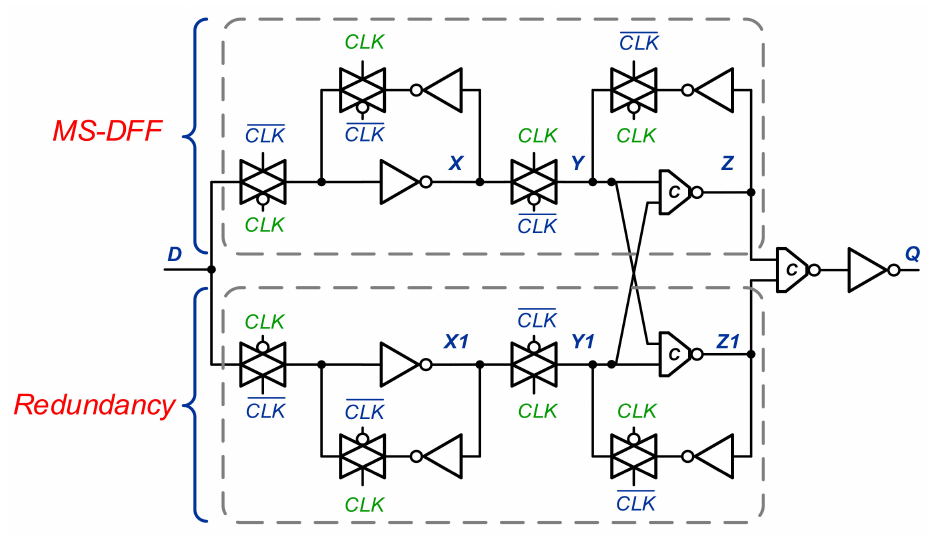
Figure 8. Schematic diagram of DM-DFF.